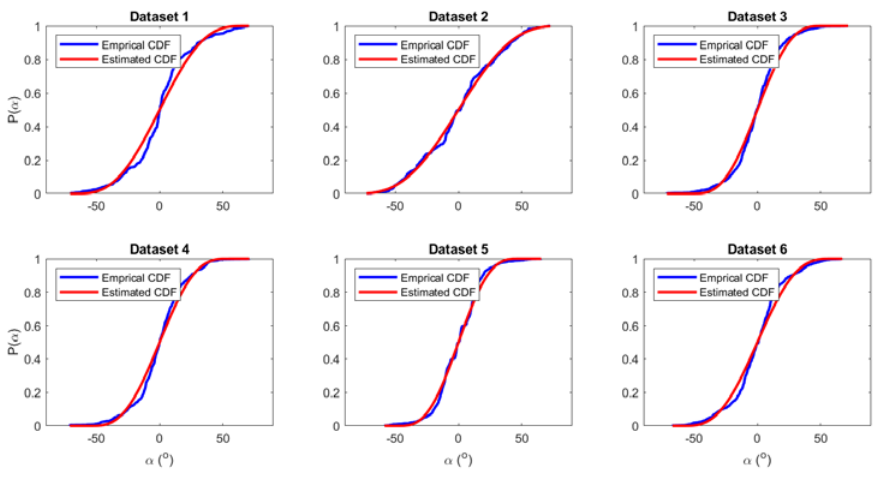
Figure 9. Empirical and estimated cumulative distribution functions